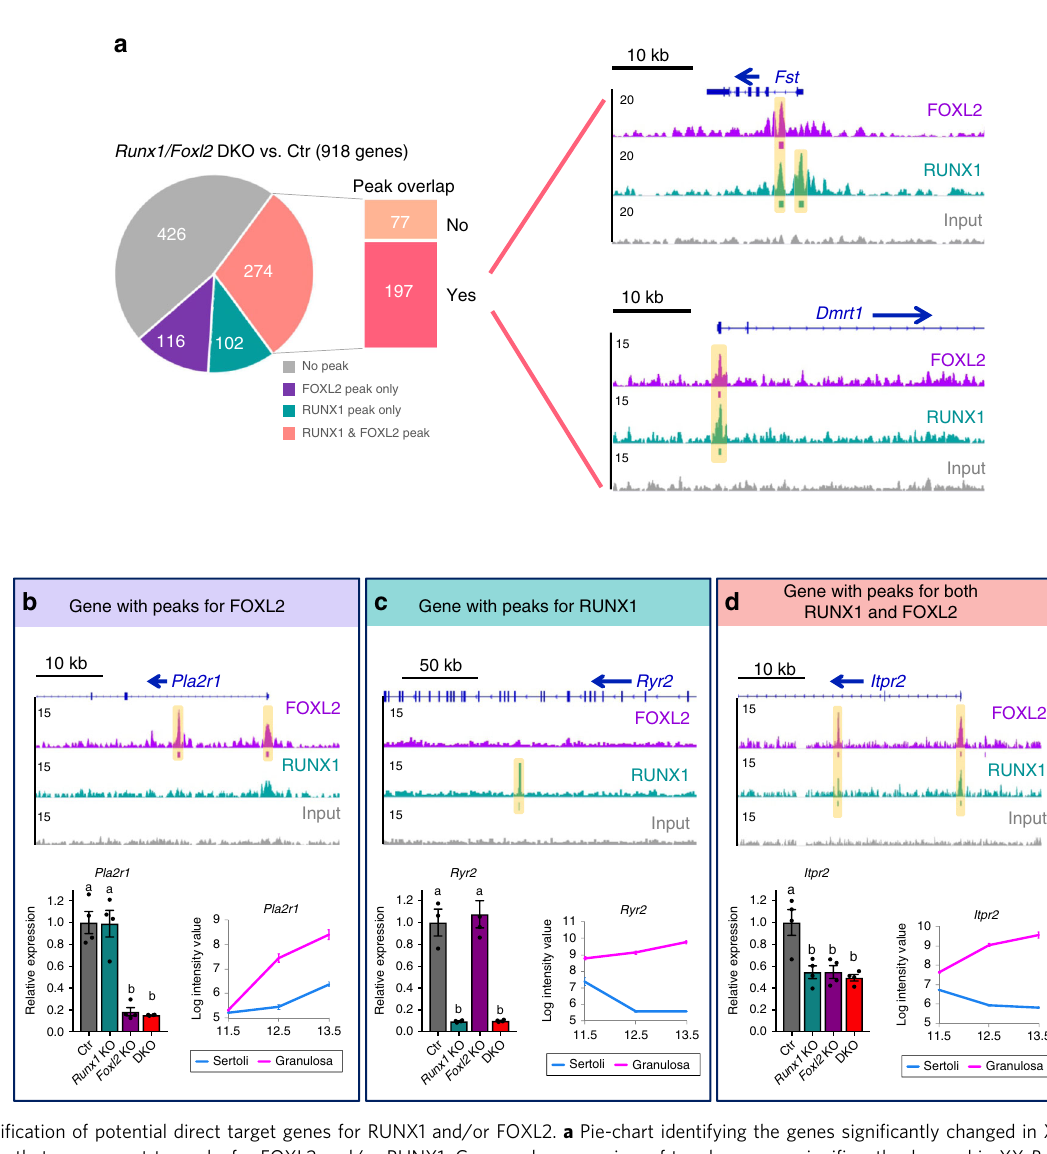
Fig. 9 Identi fi cation of potential direct target genes for RUNX1 and/or FOXL2. a Pie-chart identifying the genes signi fi cantly changed in XX Runx1/Foxl2 DKO gonads that are nearest to peaks for FOXL2 and/or RUNX1. Genome browser view of two key genes signi fi cantly changed in XX Runx1/Foxl2 DKO gonads and bound by RUNX1 and FOXL2 in E14.5 ovaries. Blue arrows: gene orientation; orange highlighted area: signi fi cant binding peaks identi fi ed by HOMER. b – d Examples of genes affected in XX Runx1/Foxl2 DKO gonads and bound by FOXL2 or/and RUNX1. For each gene, we show the genome browser view of RUNX1 and/or FOXL2 binding in E14.5 ovaries, the gene expression by quantitative PCR in XX Runx1/Foxl2 single and double knockouts gonads at E15.5 ( n = 4/genotype; mean ± SEM; one-way ANOVA, p < 0.05.; bars with different letters ( a , b ) are signi fi cantly different) and the gene expression in fetal Sertoli and granulosa cells from E11.5 to E13.5 40 . Source data are provided as a Source Data fi